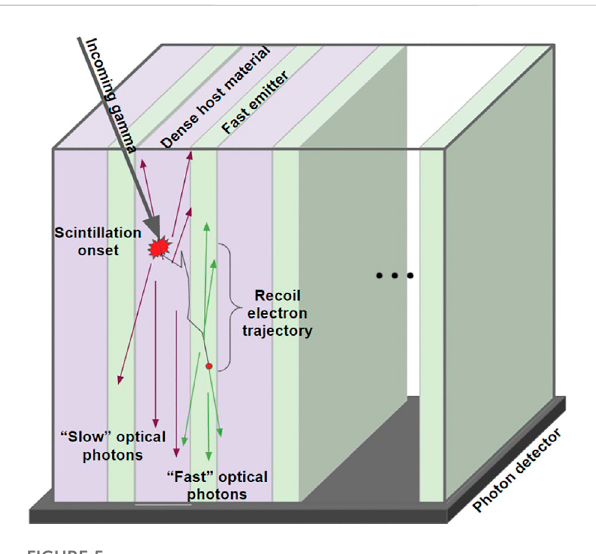
FIGURE 5 Layeredcompositescintillatorconsistingofadensehostmaterial (purple) such as BGO or LYSO alternated with a fast emitter (green) such as EJ232 or BaF 2 . Reproduced under CC-BY 4.0 license from